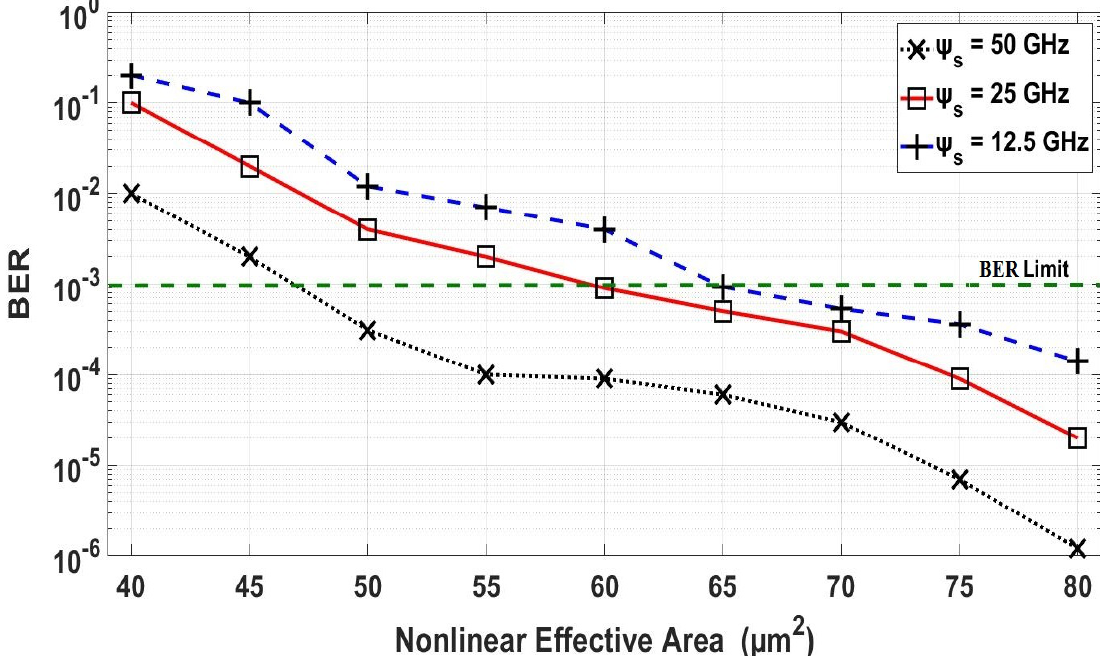
Figure 7. BER results for a range of Nonlinear effective area at 50, 25 and 12.5 GHz channel spacings (32